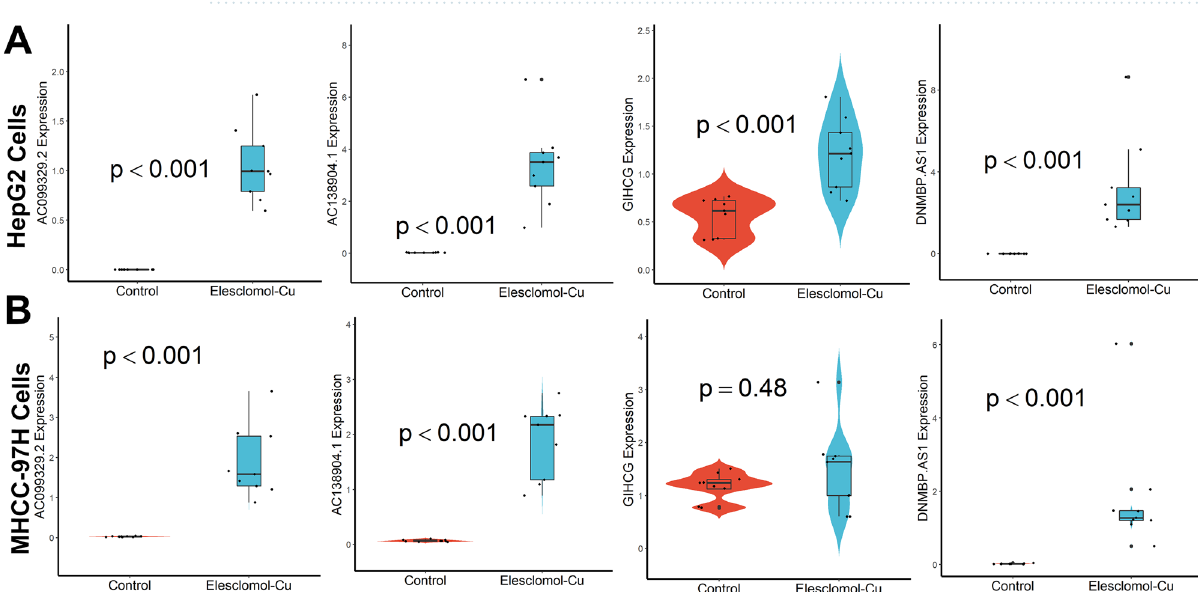
Figure 10. qRT-PCR assay of the lncRNAs expression levels in the constructed Cuproptosis cell model. ( A ) In HerpG2 cells, ( B ) In MHCC-97H